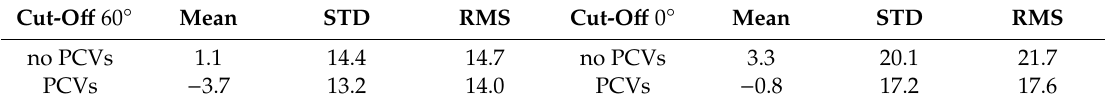
Table 4. Orbital SLR residuals statistics [unit: mm].